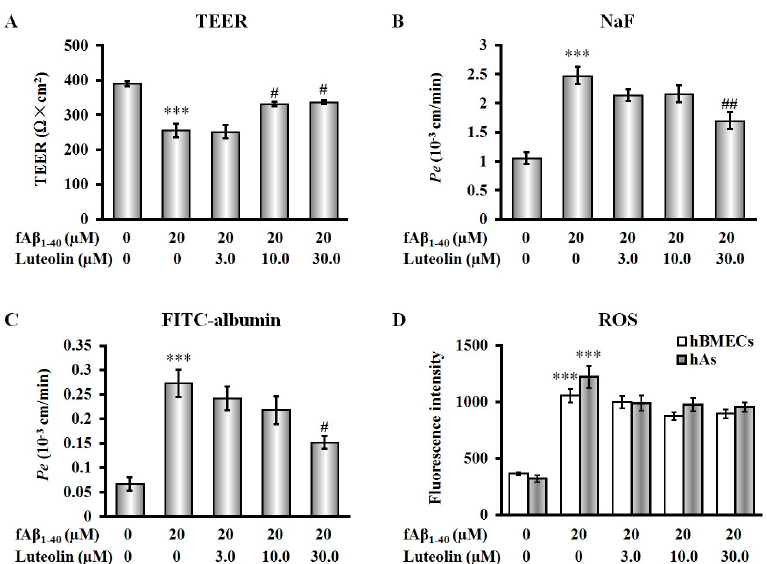
Figure 3. Luteolin improves blood-brain barrier (BBB) function but does not scavenge intracellular reactive oxygen species (ROS) in co-culture against fA β 1–40 -induced toxicity. ( A ) Luteolin decreased the transendothelial electrical resistance (TEER) value at concentrations of 10.0 µmol/L and 30.0 µmol/L; ( B ) Luteolin decreased the transendothelial permeability for fluorescein sodium (NaF) by preserving the reduction in value of the endothelial permeability coefficient ( Pe ) at a concentration of 30.0 µmol/L; ( C ) Luteolin decreased fluorescein isothioyanate labeled albumin (FITC-albumin) indicated by Pe value at a concentration of 30 µmol/L; ( D ) Luteolin does not reduce intracellular ROS levels in hBMECs and hAs in co-culture against fA β 1–40 -induced toxicity. Data are expressed as mean ± SEM; n = 4; *** p < 0.001 vs. control; # p < 0.05; ## p < 0.01; vs. fA β 1–40 .